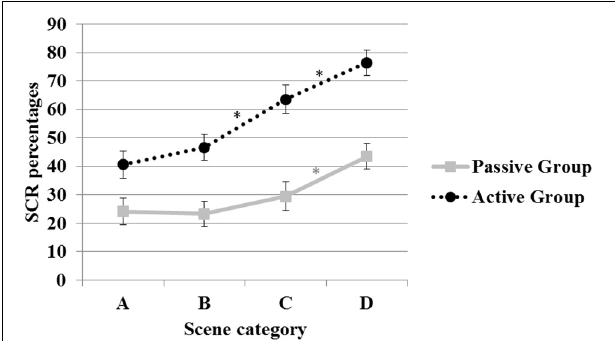
FIGURE 3 | Percentages of SCRs shown by participants in each scene category, depending on the degree of risk developed. Error bars represent standard errors. Asterisks indicate the significant differences, as attested by the post hoc tests, within each group. The differences between groups are significant in each scene category.